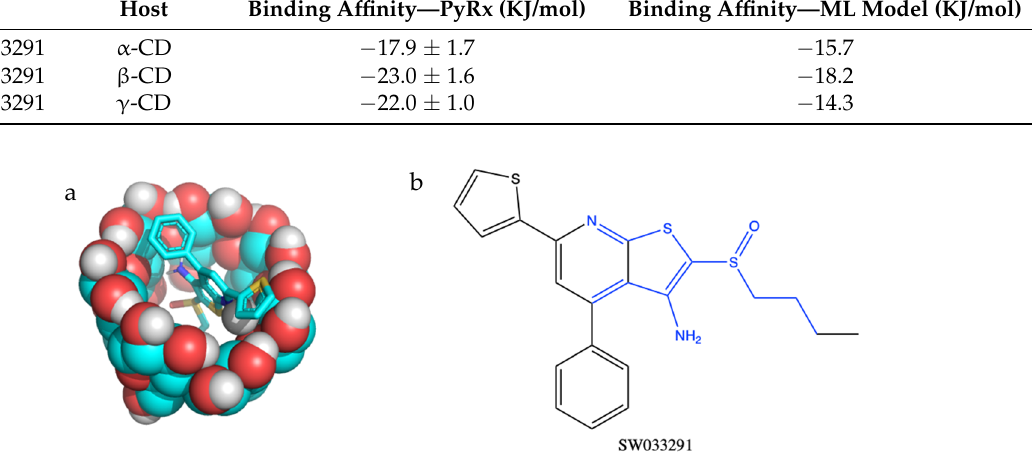
Figure 2. ( a ) Molecular structure in silico model demonstrating inclusion complex formation between the small-molecule drug SW033291 binding to the inner pocket of β-cyclodextrin. ( b ) Regions of SW033291 in blue are complexed within the cyclodextrin ‘pocket’.